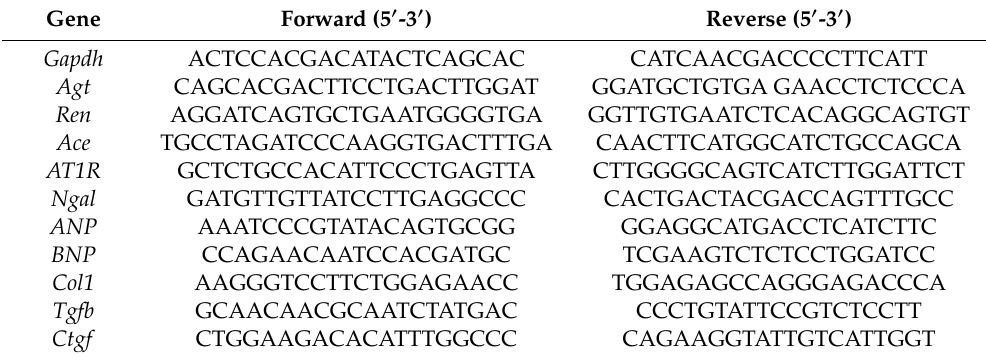
Table 2. Rat primer sequences for quantitative real-time PCR analysis.